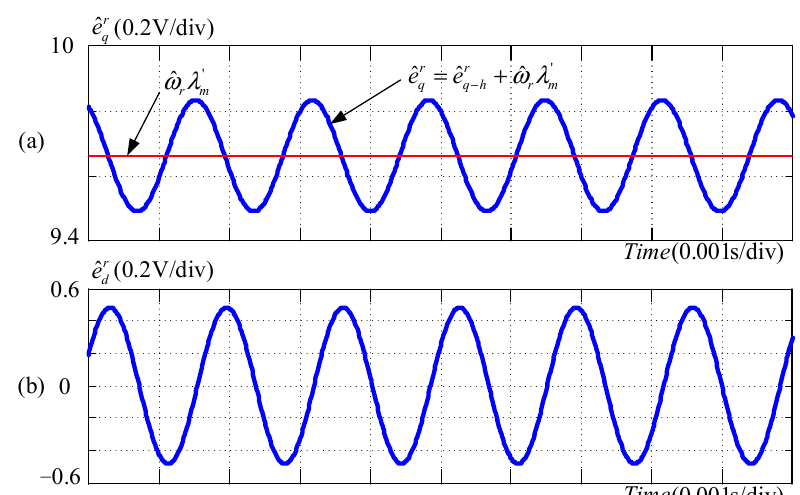
Figure 5. Measured and estimated results of induced EMF of three-phase permanent-magnet syn- chronous motor driven by the prime mover at a speed of 1500 rpm: ( a ) estimated ˆ ˆˆ cos induced EMF; ( b ) m